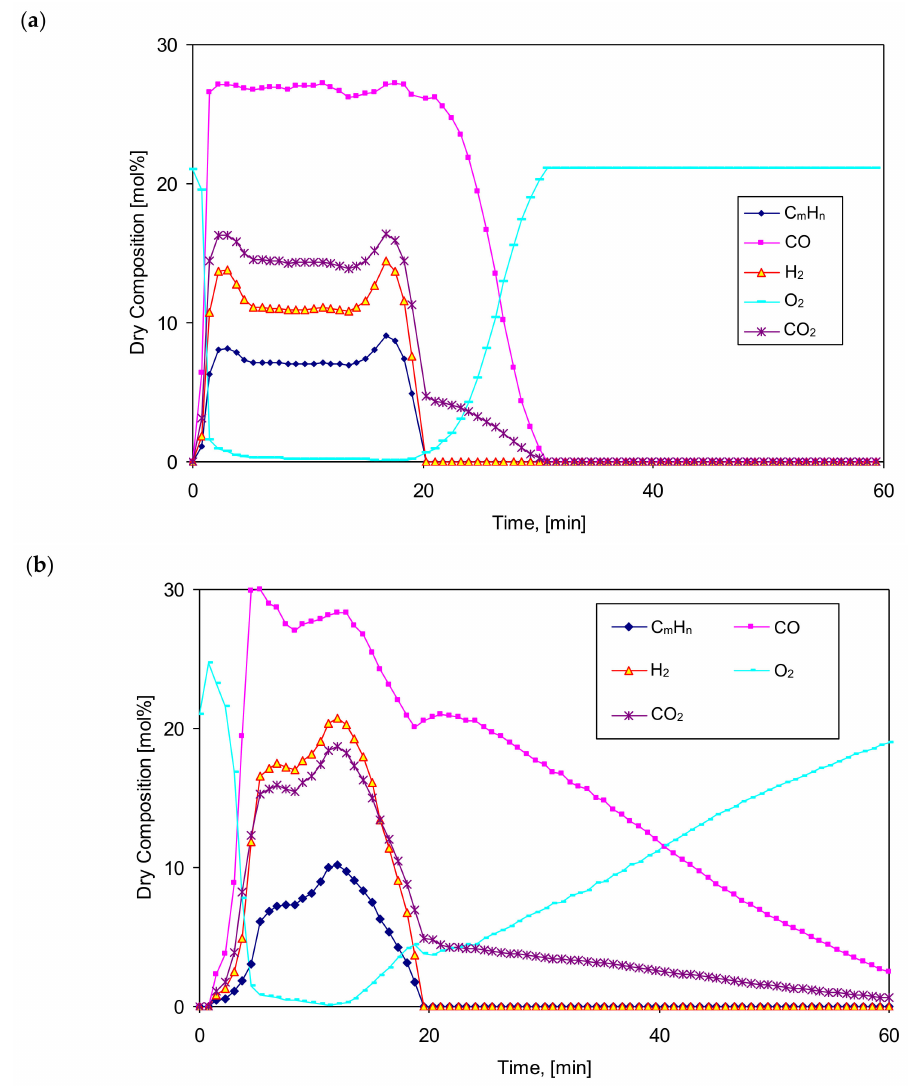
Figure 11. The influence of pellet size on the gasification process at the oxidizer volumetric flow rate at 50 Nm 3 /h and temperature 830 ◦ C: ( a ) diameter 6 mm; ( b ) diameter 19